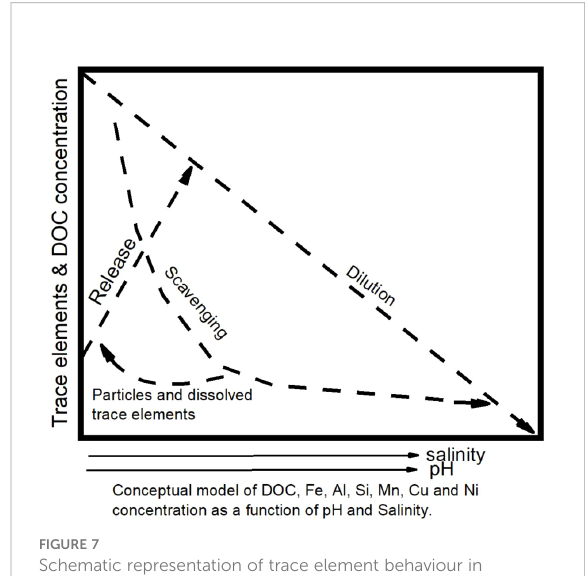
FIGURE 7 Schematic representation of trace element behaviour in blackwater river and estuarine system.